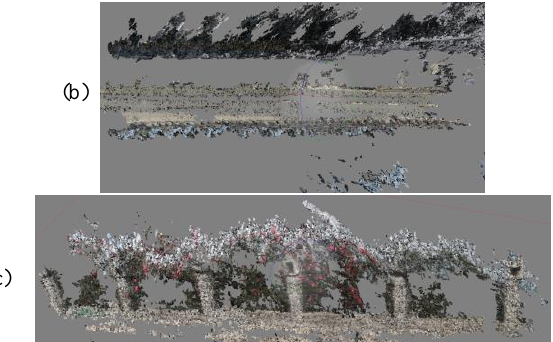
Figure 7. Generated point clouds of (a) billboards; (b) road; and